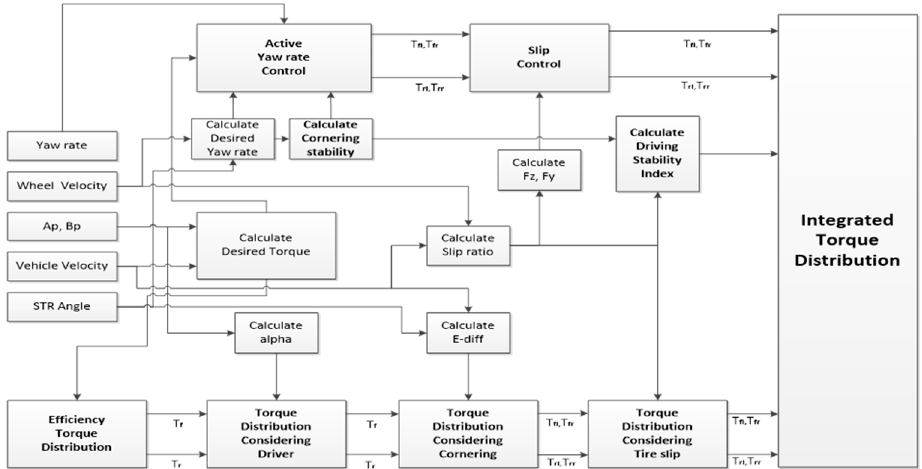
Figure 7. Integrated driving torque distribution strategy considering driving efficiency and stability.